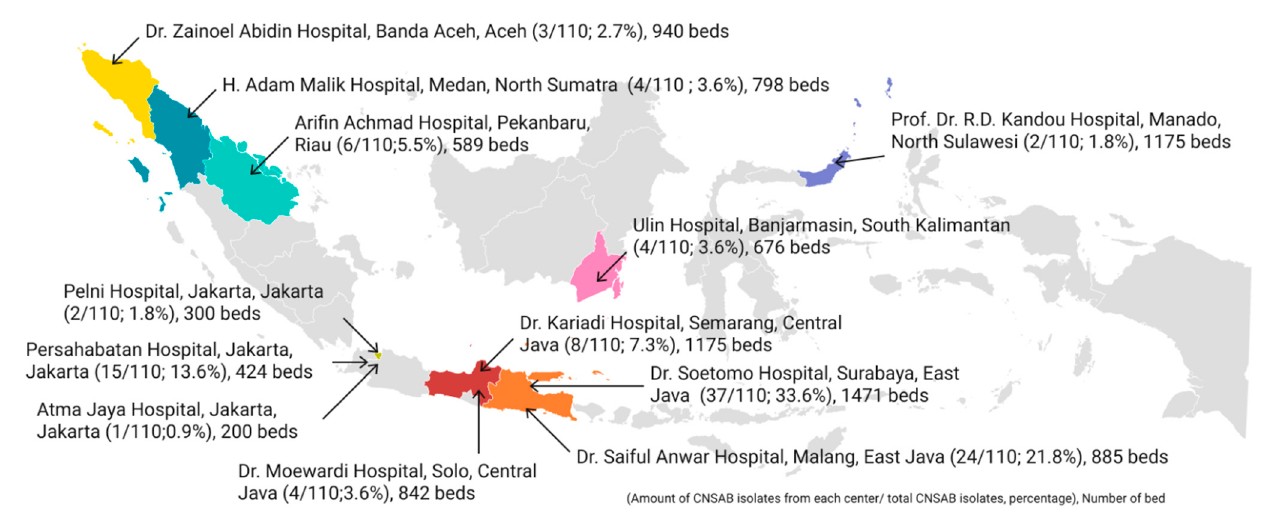
Figure 1. Distribution of CNSAB isolates with confirmed gyrB gene from each hospital in Indonesia ( n = 110). The percentage is calculated as the number of gyrB -positive isolates from each hospital divided by the total number of isolates carrying the gyrB in this study. The number of beds from each hospital are provided to increase understanding of the profile of the study site.